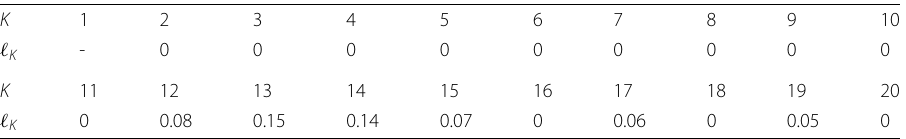
(cid:4) (cid:5) (cid:12) Q [ M ] 1 , Q [ M ] 1 for K = 2, 3, . . . , 20